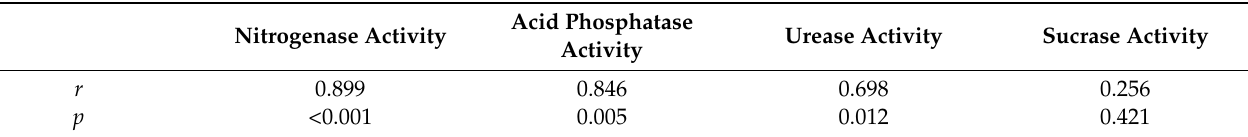
Table 1. Correlations between the soil enzyme activity (nitrogenase, acid phosphatase, urease, and sucrase) and the ability of ramie to tolerate poor soil, expressed by the normalized field performance index (NFPI).